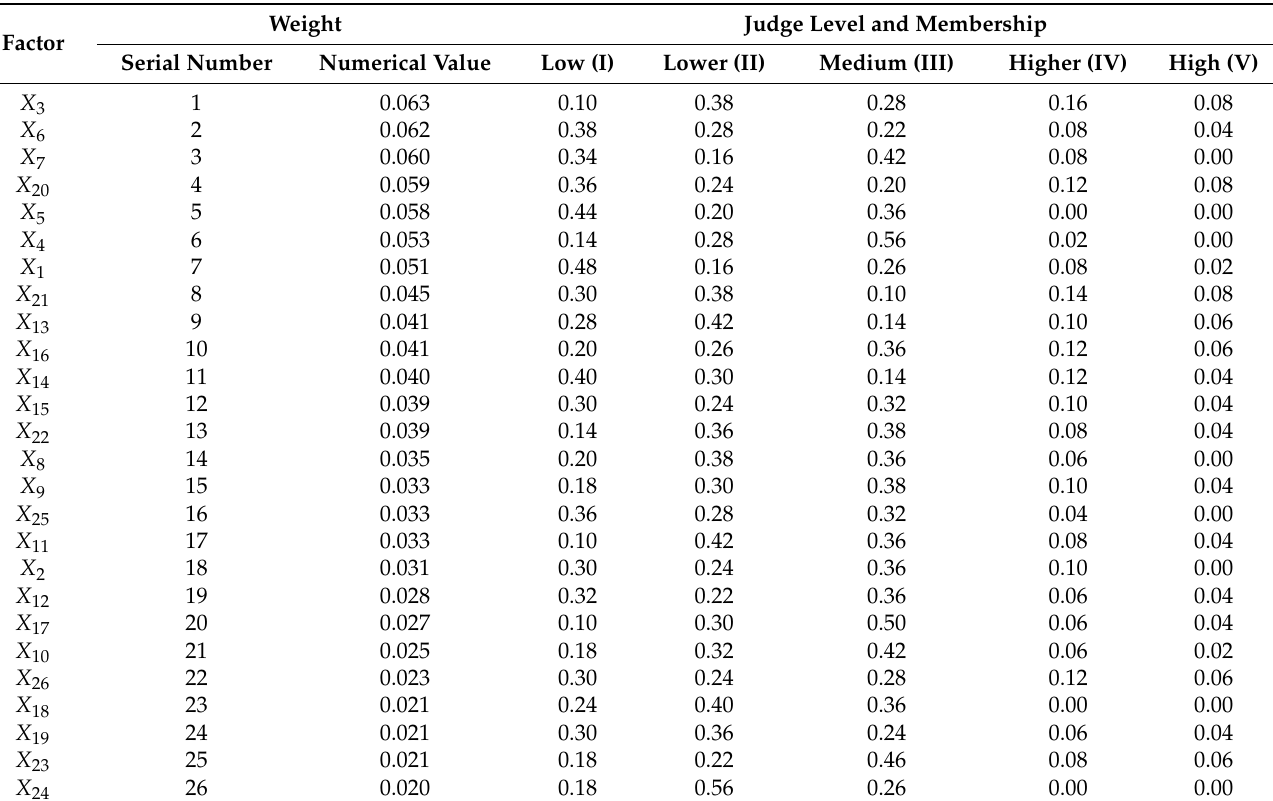
Table 15. Sub-factors comprehensive weight ranking and membership